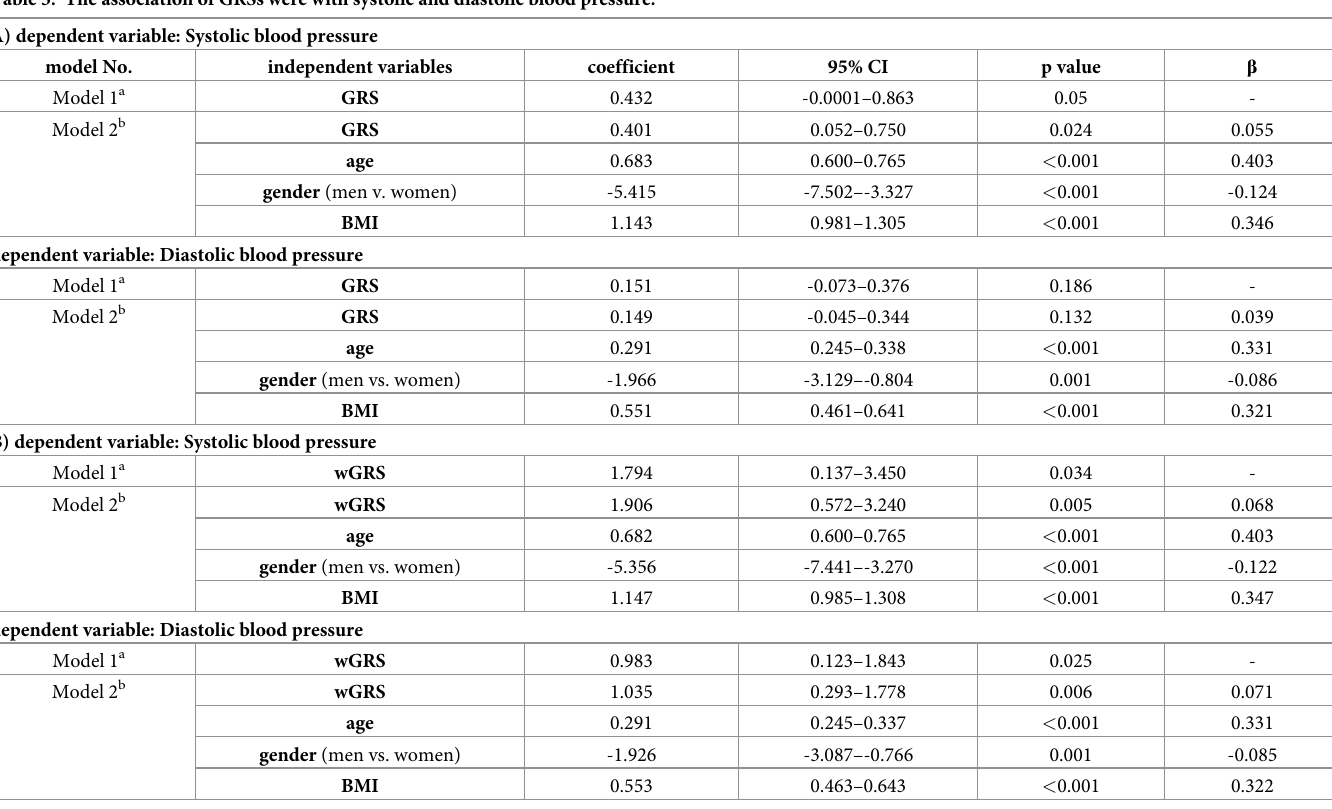
β : relative strength of predictors a Model 1 is unadjusted b Model 2 is adjusted for age, gender and BMI The GRS, wGRS, age, BMI, systolic and diastolic blood pressure values were non-normally distributed and were transformed using a two-step approach suggested by Templeton